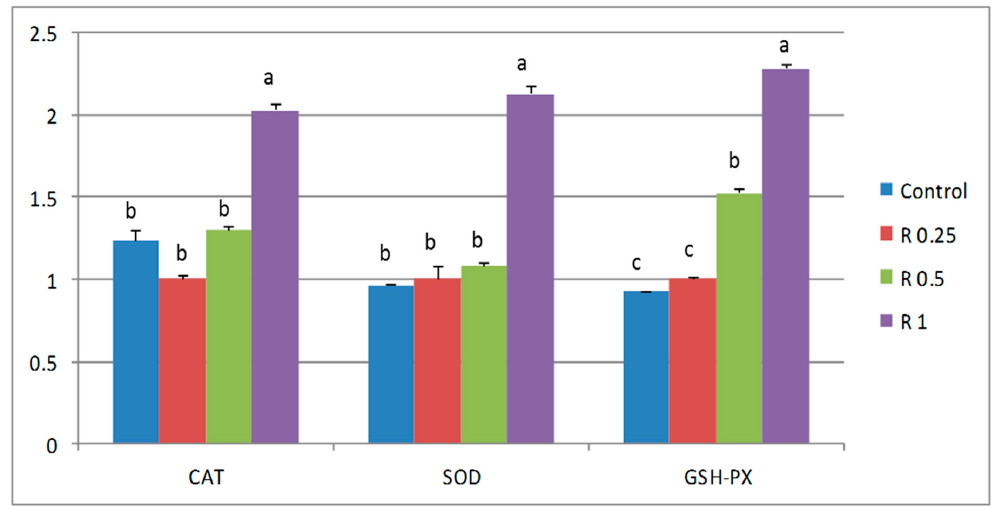
Figure 1. Effect of dietary rutin on the relative expression of CAT , SOD and GSH-PX in broiler livers. Each bar carrying different letters (a, b, c) was significantly different ( p < 0.05) (mean ± standard error, n =